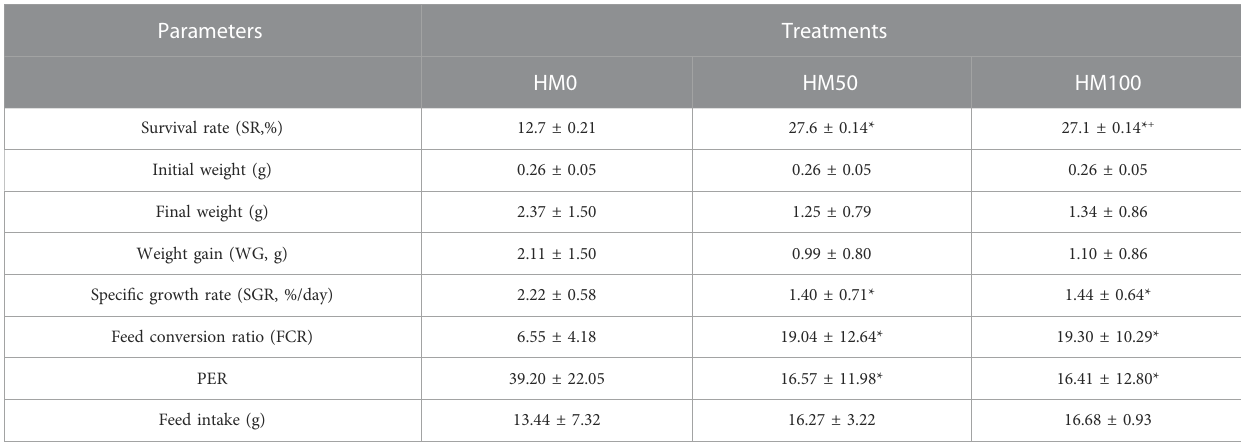
TABLE3Growthperformanceandfeedutilizationef fi ciencyofjuvenile P.leptodactylus fedwiththreedifferentdietswithdifferentsubstitutionlevelsof H.illucens